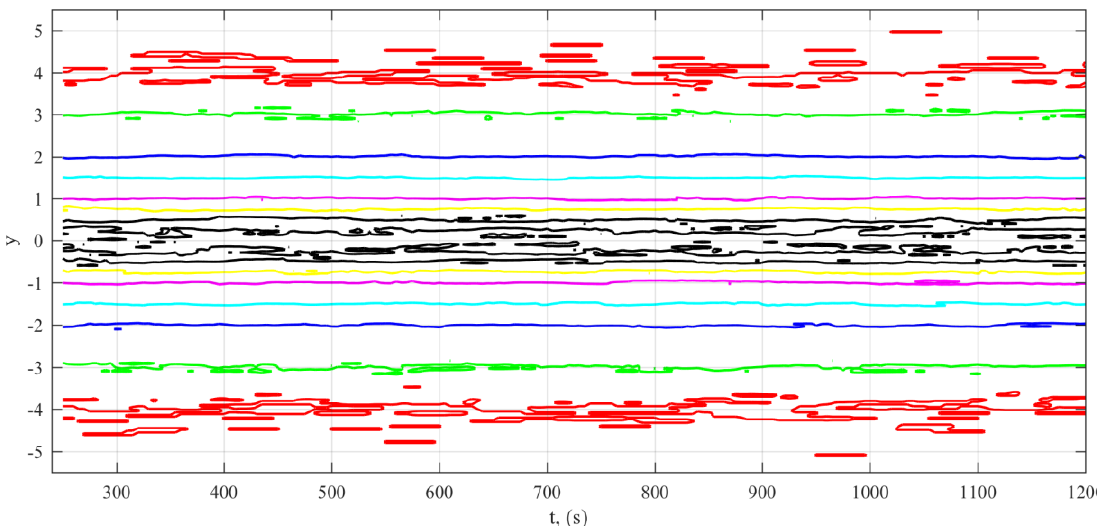
Figure 7. White noise after normalization by the level. Lines of equal probability for consecutive PDF for T = 10 s. This is lines of equal probability of the values of w(y): 0.000134 (red), 0.004432 (green), 0.053991 (blue), 0.1295 (cyan), 0.241971 (magenta), 0.3521 (yellow), 0.3867 (black). For the Gaussian distribution with the mean equal to 0 and variance equal to 1, this would be corresponding to the straight lines—also in accordance with values of y: ±4, ±3, ±2, ±1.5, ±1, ±0.5, ±0.25.